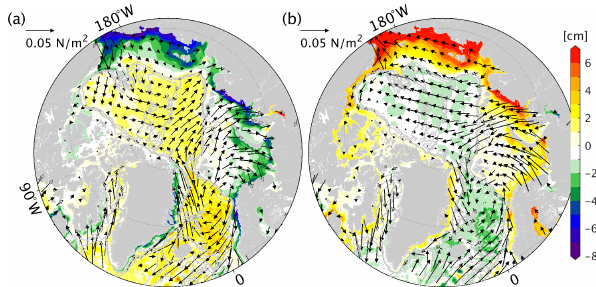
Figure 9. SLA (shading) and wind stress anomalies (vectors) to the climatology averaged from (a) June to August and (b) December to February. The daily output of ATLARC4km is